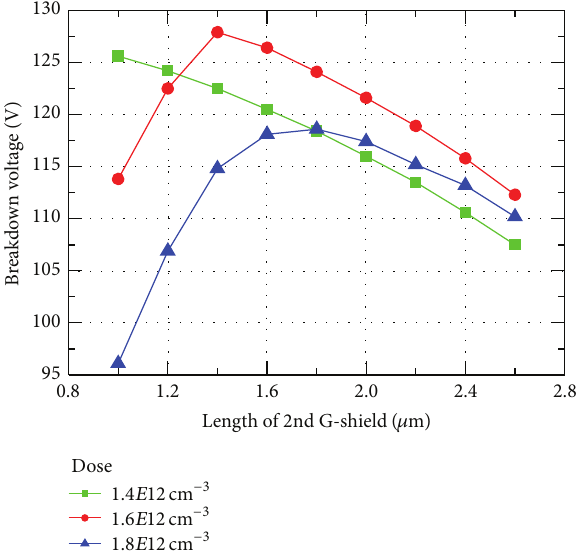
Figure 4: Relationship between the breakdown voltage and length ofthe2ndG-shieldwithrespecttodifferentimplantdosesforagiven implant energy of the N-drift